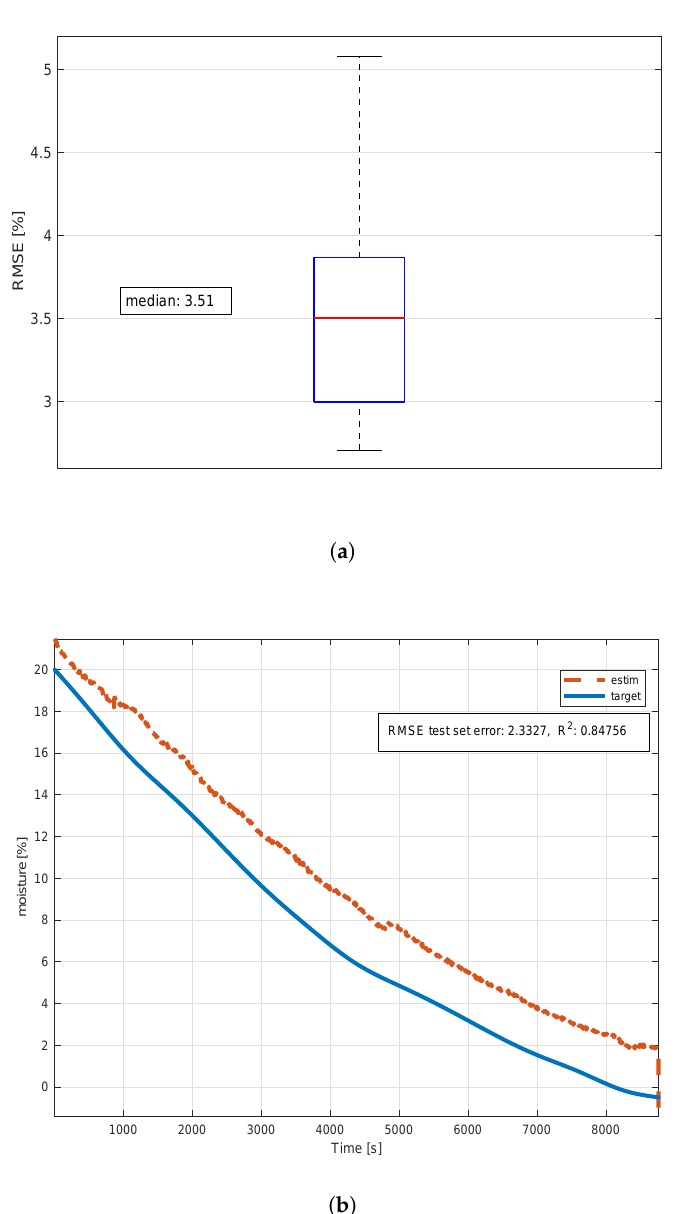
Figure 9. Examples of results using Method 2: ( a ) Performance in terms of RMSE distribution (in % moisture content) using symbolic regression with a GP approach with all input signals available; the increasing size of the input signals from left to right. ( b ) Example of laundry moisture content estimation using all predictors available; on the y-axis the moisture content in